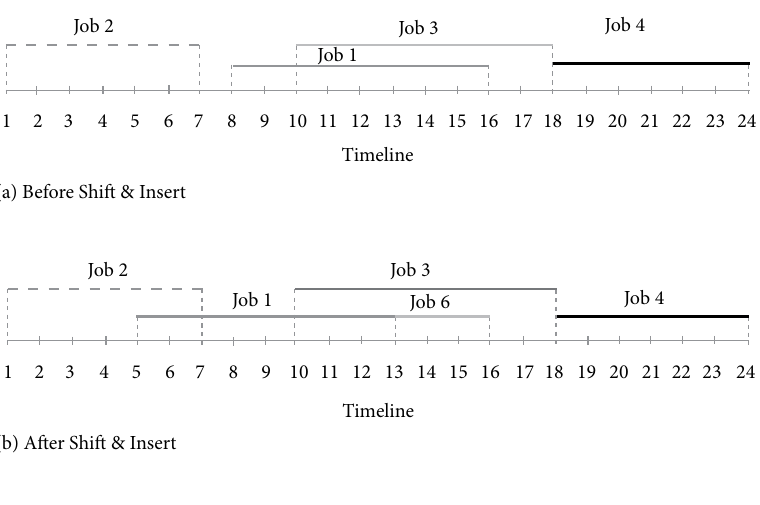
Fig. 7. Example for demonstrating the execution of the Shift & Insert algorithm